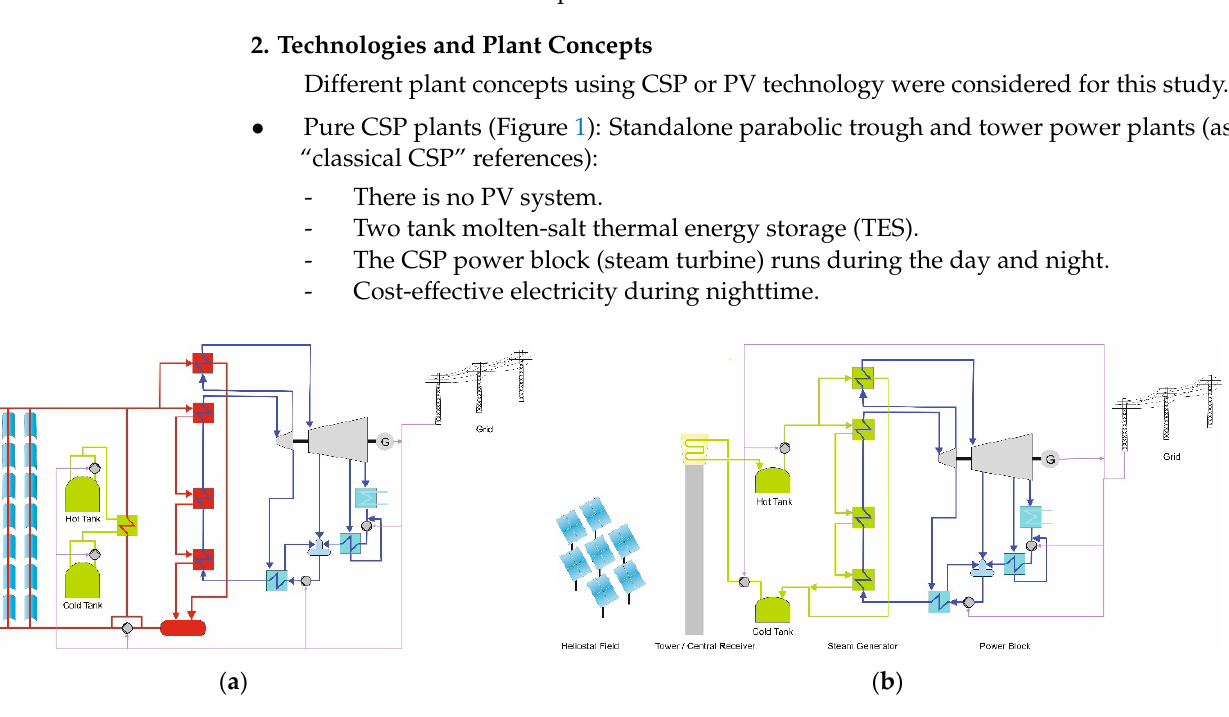
Figure 1. Pure concentrated solar power (CSP) plants: ( a ) Parabolic trough (PT); ( b ) Central receiver tower (CRT).